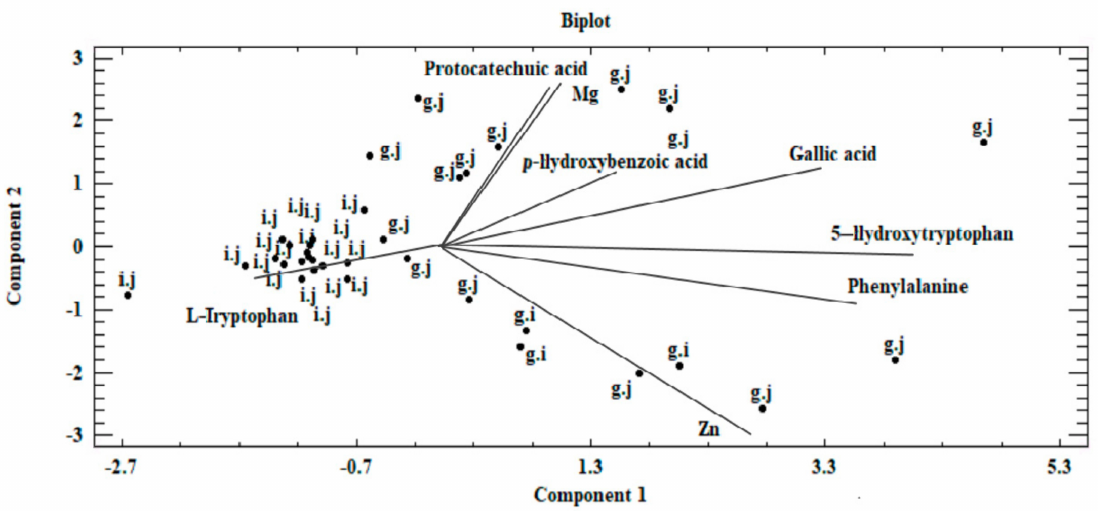
Figure 6. Biplot—graph on a two-dimensional plane, presenting the existing correlation in the analyzed dataset between components marked in the biomass obtained on liquid media enriched with inorganic salts for in vitro cultures of Pleurotus citrinopileatus , Pleurotus djamor , and Pleurotus pulmonarius and their extraction into artificial digestive juices (g.j—gastricjuice, i.j—intestinal